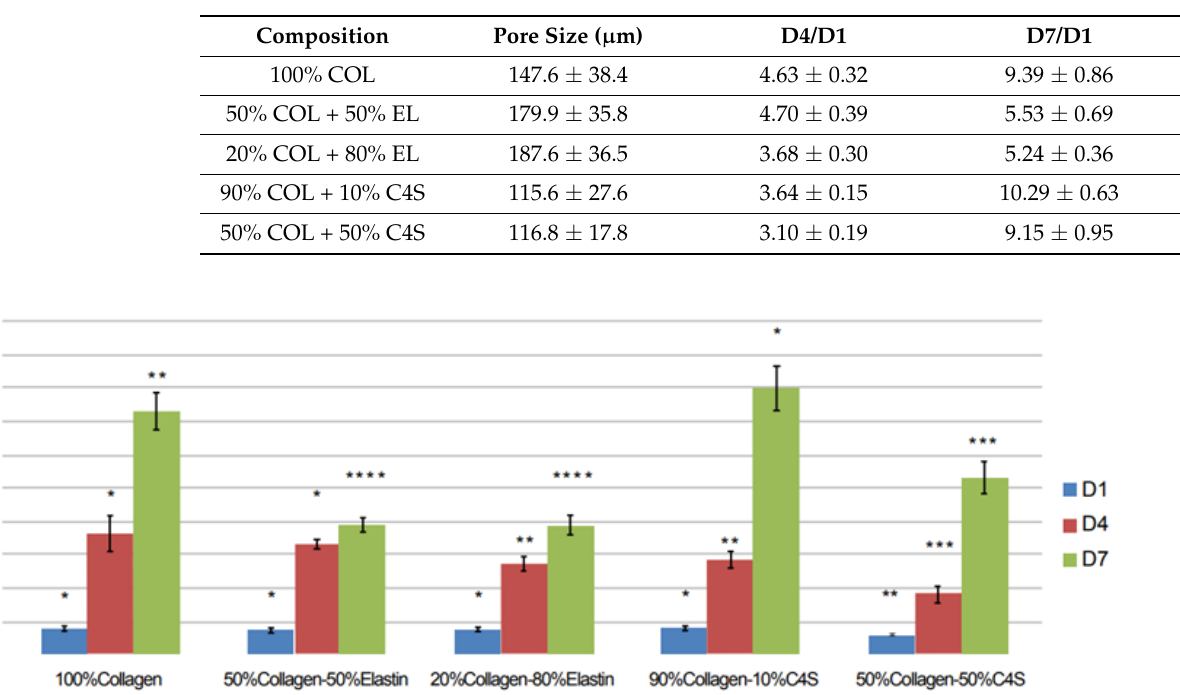
Table 7. Scaffolds pore size and percentage of AlamarBlue reduction of D4 and D7 normalized to values of D1. Adapted with permission from ref. [230]. Copyright 2012, Hilaris.